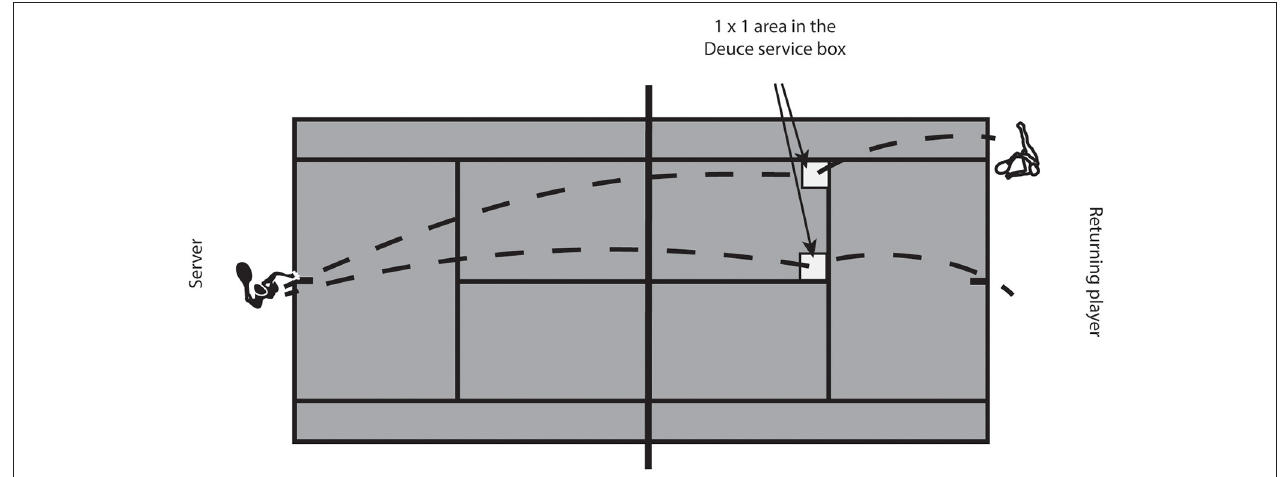
FIGURE 1 | Experimental setup. The position of the server and returning player are presented, as well as areas where the server was required to position his serve in the returning player service